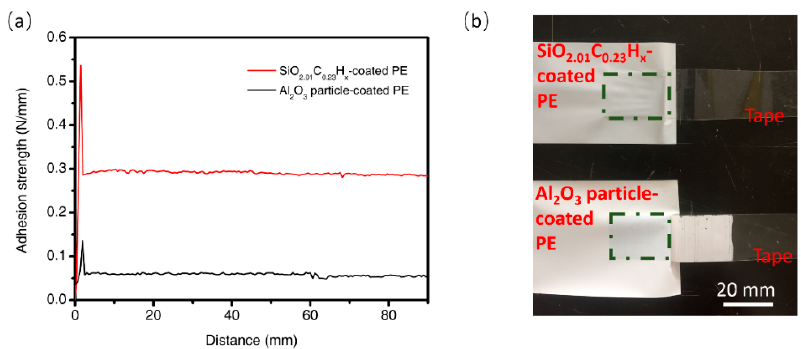
Figure 5. ( a ) Adhesion strengths of different coating samples; ( b ) the optical photo of the separators and tapes after the 180° peel-off